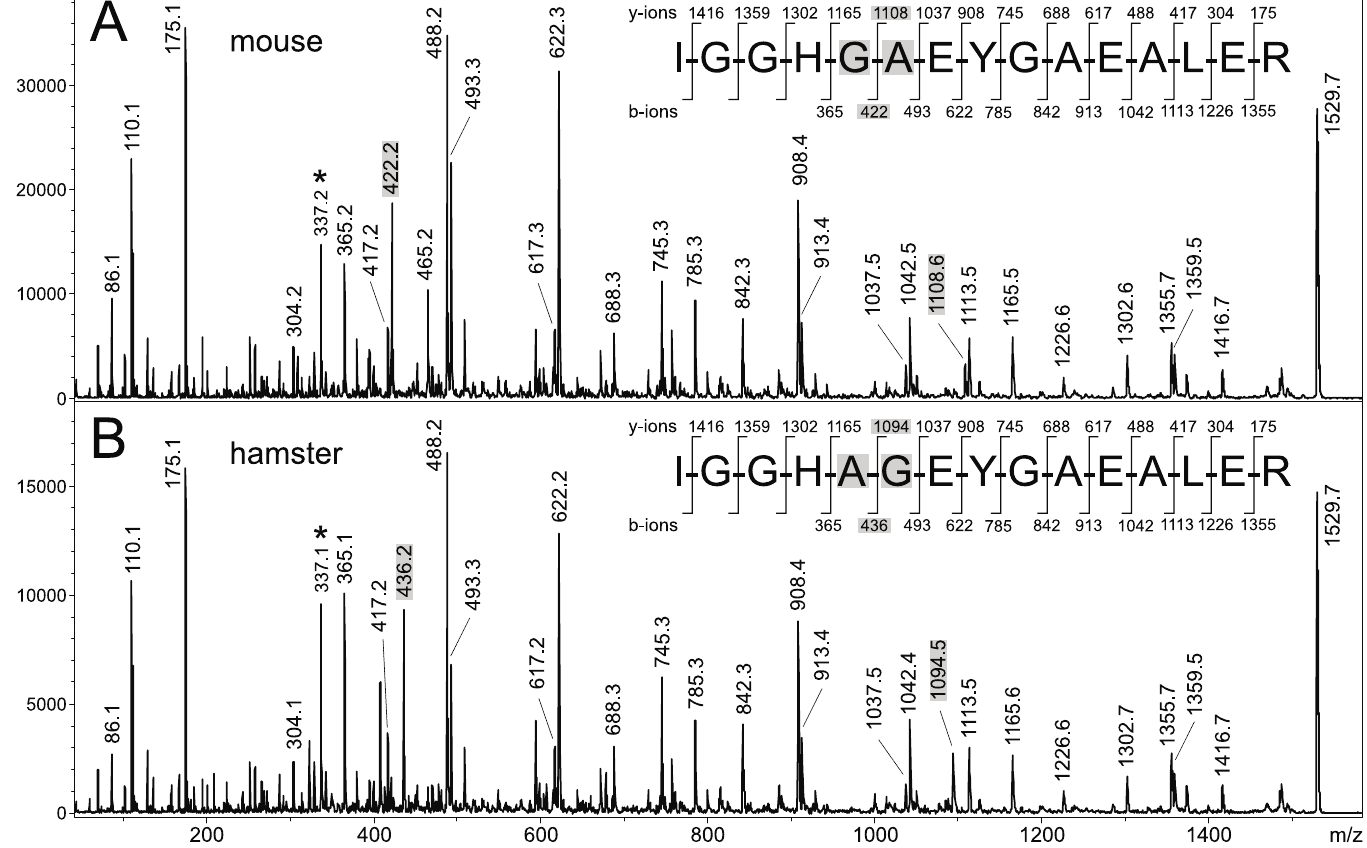
Fig 4. Host blood identification using MS/MS sequencing of trypsin-generated peptides from homogenized engorged abdomens. The peptide sequences of host hemoglobin were proved by almost complete series of b- and y-type fragment ions [22]. The approach is even capable to distinguish isobaric peptide sequences as shown on the example of HBA fragment from SKH1 mouse (A) and hamster (B) with the same protonated mass [M+H] + = 1529.7. The peptides differ in only two amino acids which are highlighted in grey, as well as the ions verifying those differences. The a 4 fragment ions are marked by